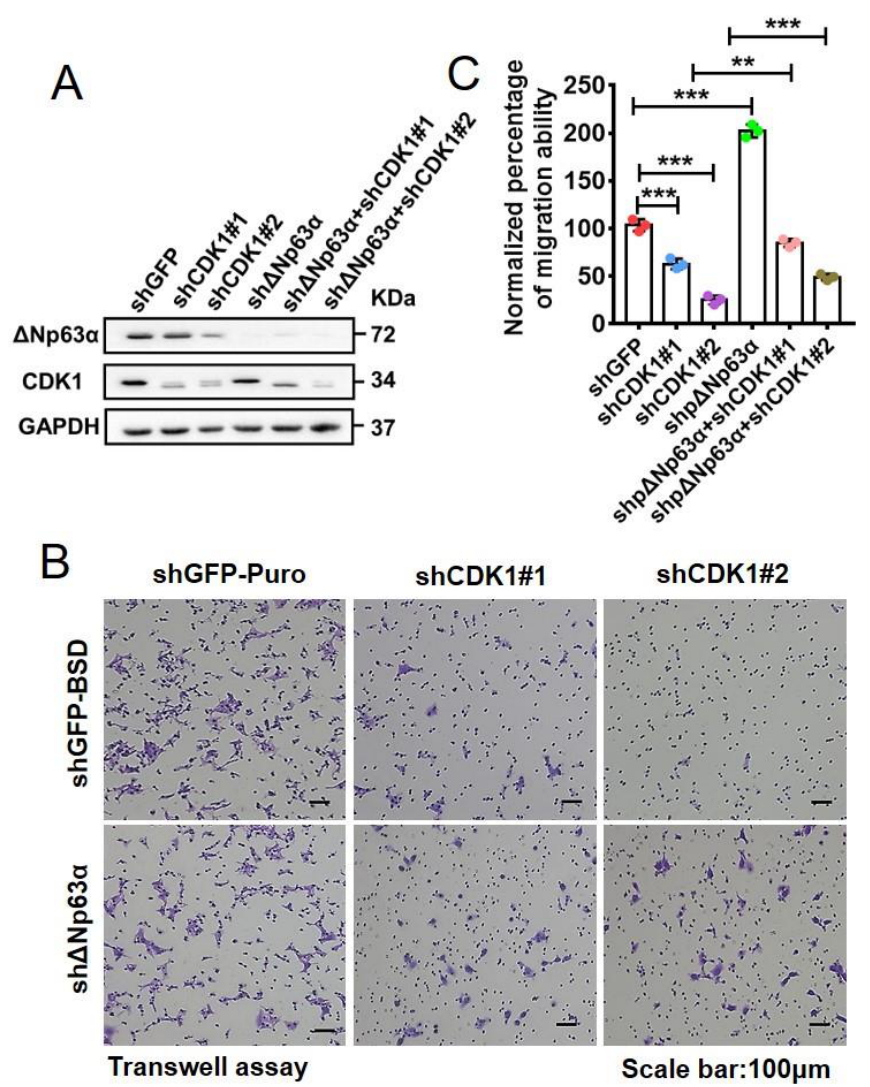
Figure 7. Knockdown of ∆ Np63 α significantly rescues inhibitions of HNSCC cell migration induced by CDK1 depletion. ( A ) CDK1- and (or) ∆ Np63 α -knockdown UM1 cells were constructed with lentiviral infection and identified by means of IB analysis. ( B ) UM1 cells ablated with CDK1 and (or) ∆ Np63 α were subjected to transwell assay. Representative crystal violet staining images of migrated cells on the underside were shown. ( C ) Quantification of effects of CDK1 and (or) ∆ Np63 α ablation on migration ability based on transwell assays (means ± SD, n = 3). *** , p < 0.001; **, p < 0.01.